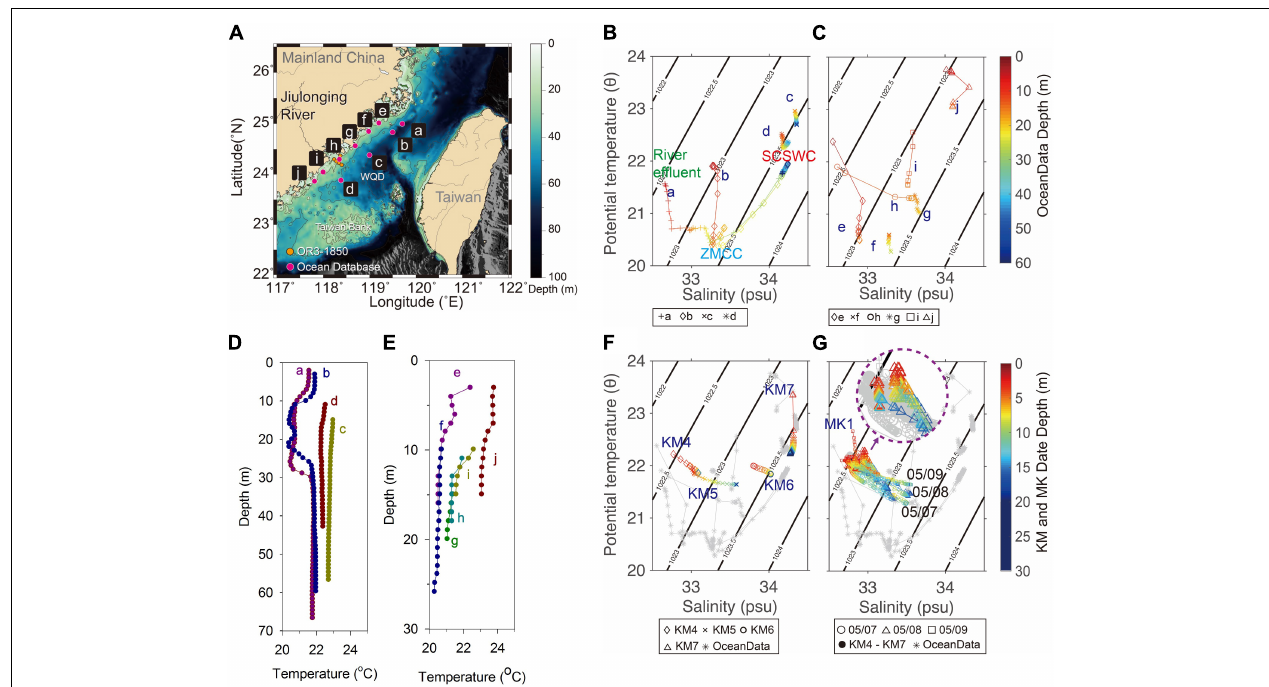
FIGURE 2 | (A) A map showing the WOD data points a ∼ j. (B) Depth-referenced θ -S diagram at offshore stations a ∼ d. The surface layer of Sta. a corresponds to coastal water. The middle layer of Sta. a and b corresponds to ZMCC water. Stas. c and d correspond to SCSWC water. (C) Depth-referenced θ -S diagram of near shore stations e ∼ j. (D) The temperature profiles at a ∼ d. (E) The temperature profiles at e ∼ j. (F) Depth-referenced θ -S diagram observed at KM4 ∼ KM7. (G) θ -S diagram observed at KM1 on 5/7 ∼ 9 showing circles (5/7), triangles (5/8), and squares (5/9). The temporal changes on 5/8 when the regime change occurred are enlarged in the dashed circle. The θ -S plots in (B,C) are plotted in the background in gray (F,G) to provide perspective to the present